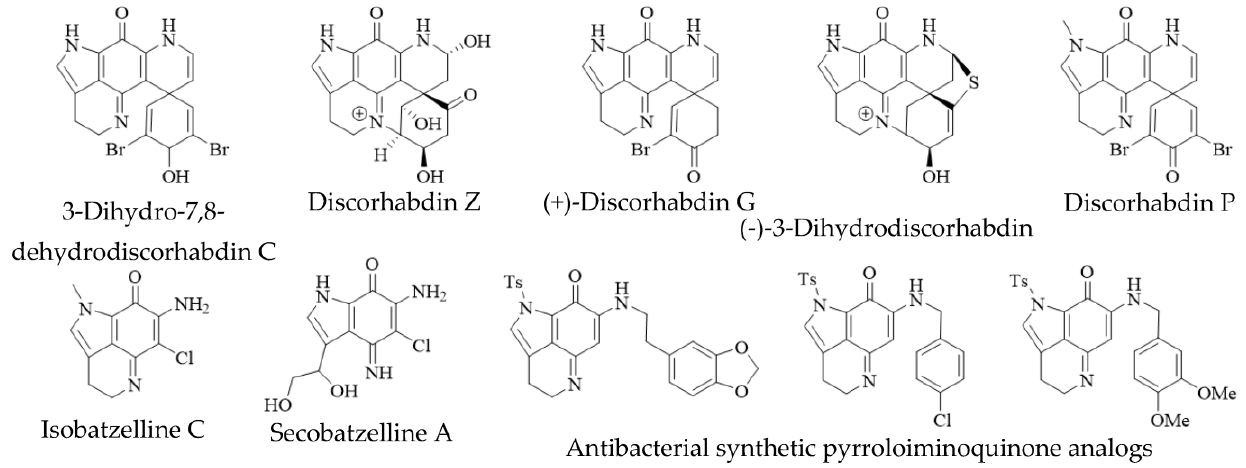
Figure 10. Selected natural and synthetic pyrroloiminoquinones with antibacterial, antiviral, antifungal or neuromodulatory potential.